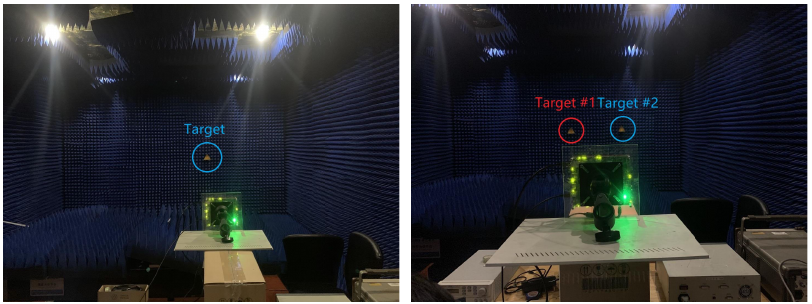
Figure 14. The experiments in Scenario 1 and Scenario